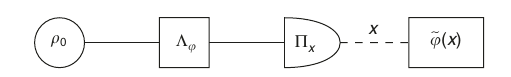
Fig. 1 A scheme of a standard quantum metrological task. A probe state ρ is subject to a parameter-dependent quantum evolution, mathematically 0 represented by a parameter-dependent quantum channel Λ φ . A POVM type measurement f Π x g x is then carried out yielding a conditional probability probability distribution p ð x j φ Þ the objective is to estimate the value of the to produce a given estimate for φ given the measurement outcome x